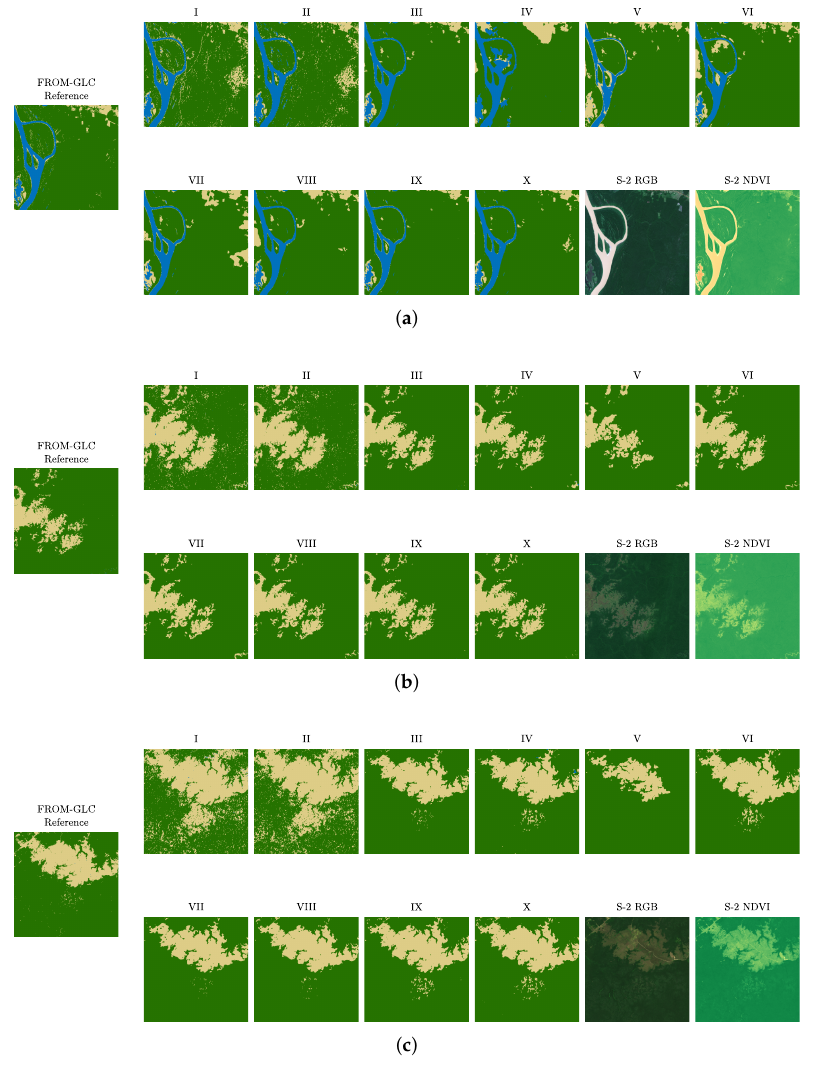
Figure 8. Comparison of the proposed approaches for the three patches ( a – c ) defined in Figure